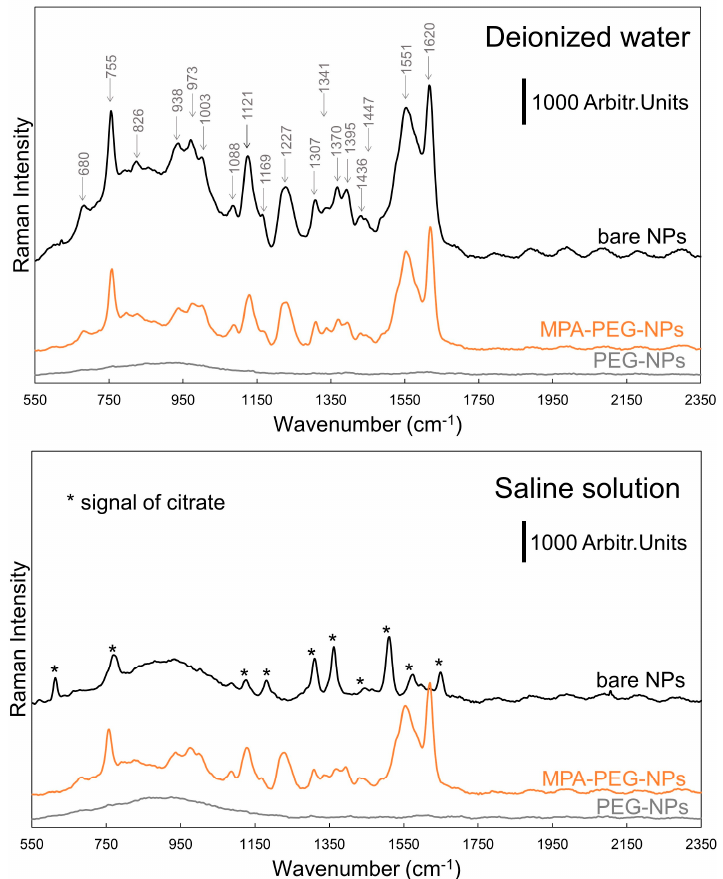
Figure 5. The typical SERS spectra of myoglobin (50 µ M) using NPs of various surface modifications in a deionized water and saline solution. Exposure time: 3 × 10 s. Concentration of NPs: 3 mg / mL. For a better visual comparison of the spectra, an o ff set, background correction, and smoothing was